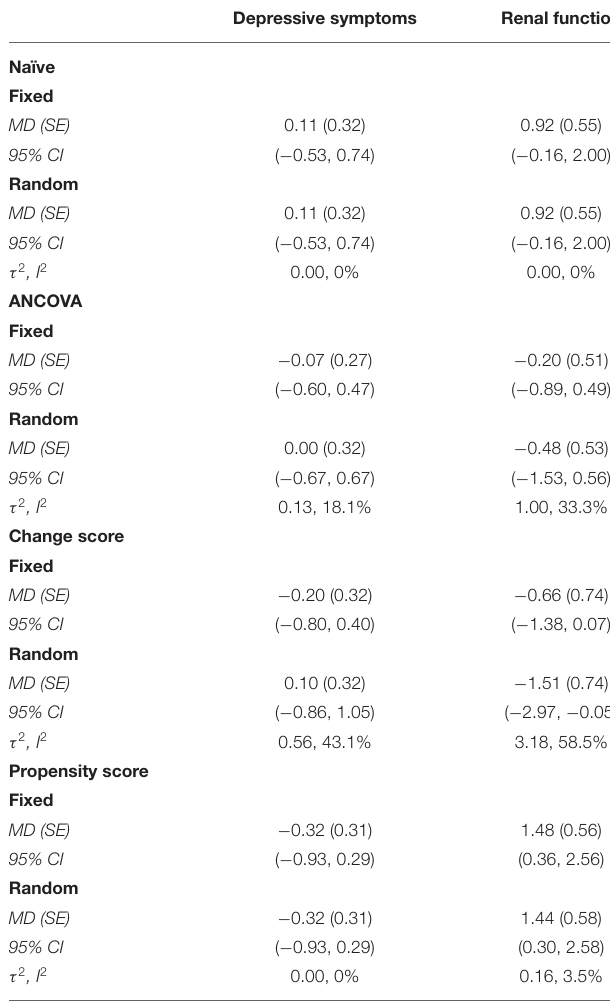
TABLE 3 | Meta-analytic results by statistical method and empirical example. Depressive symptoms Renal function Naïve